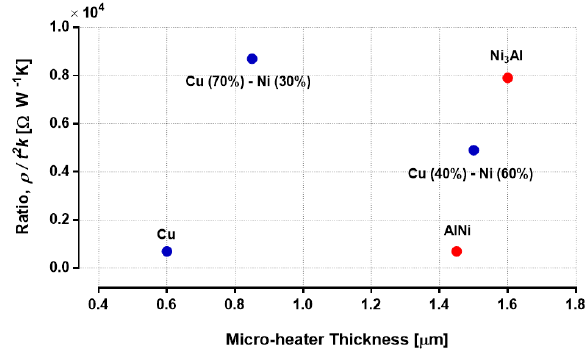
Figure2. Influentialratio( ρ / t 2 k )formaximummicroheatertemperatureplottedagainsttotalmicroheater Figure 2. Influential ratio ( ρ/t 2 k ) for maximum microheater temperature plotted against total microheater thickness associated with the material. thickness associated with the